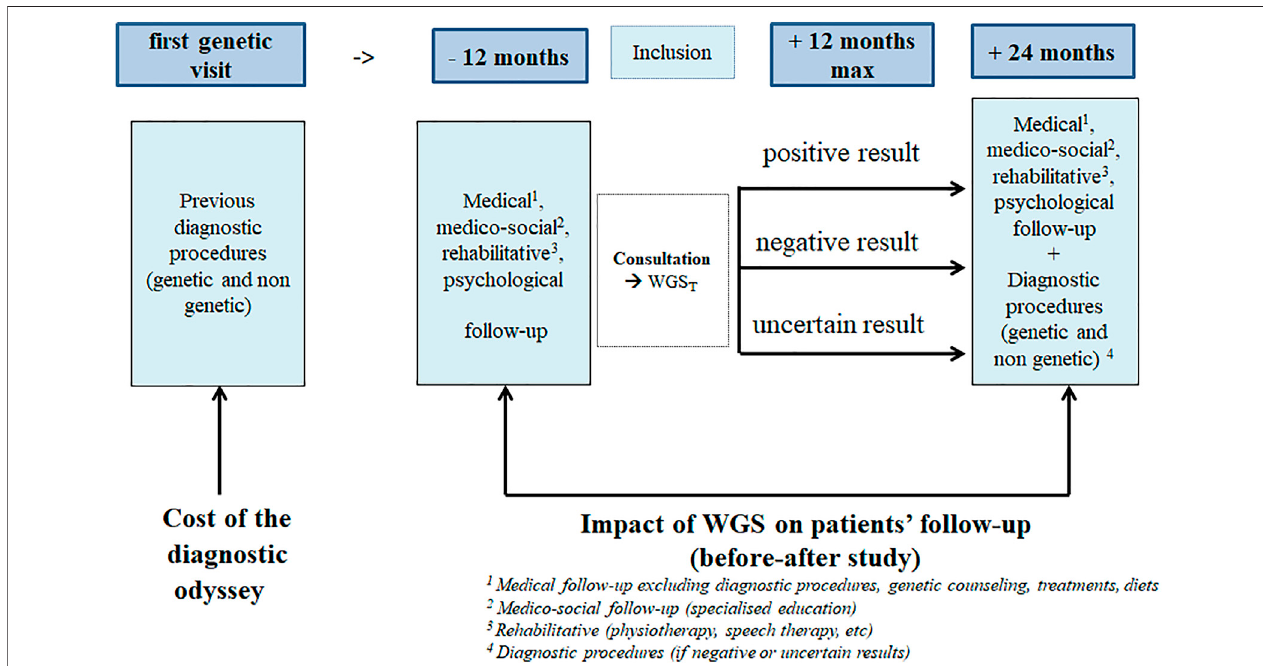
FIGURE2| Design oftheimpact ofgenome sequencing on the diagnostic odyssey and follow-up: This fi gure illustrates thedesign ofthebefore-after study aiming at assessing the impact of WGS on patients ’ follow-up (12 months after the reporting of WGS results) compared to the period of 1 year preceding the inclusion.